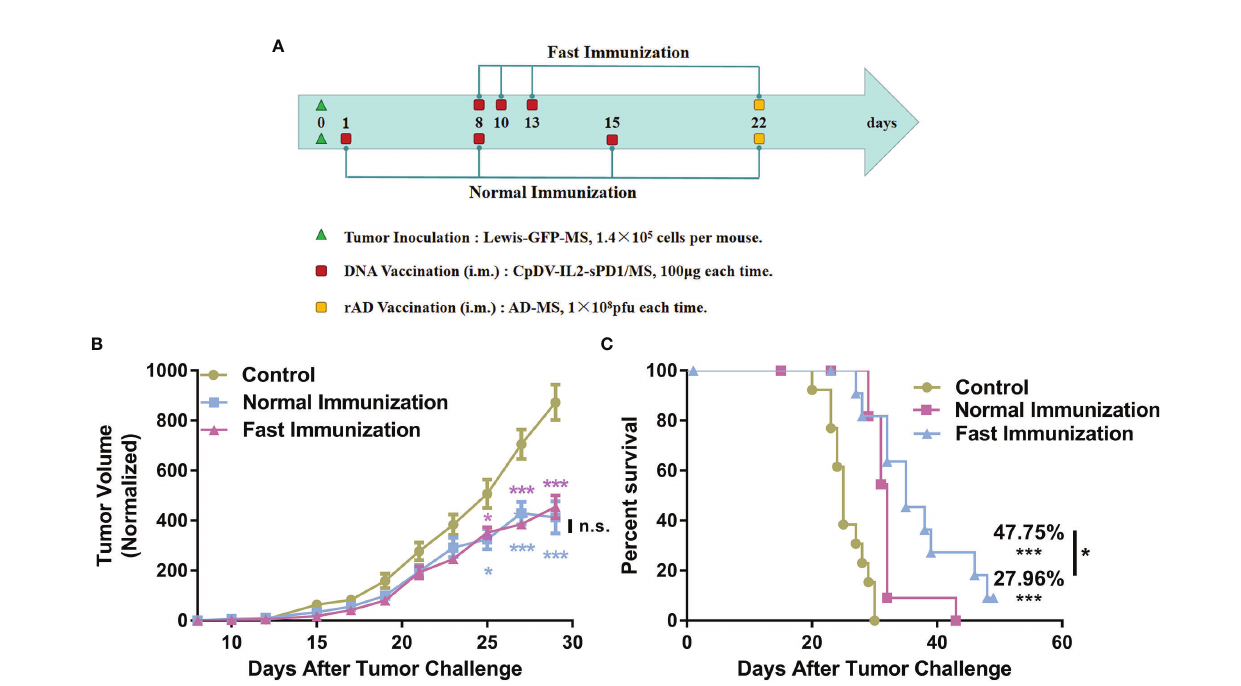
FIGURE 6 | Improved antitumor effect of the DNA vaccine under the fast immunization strategy, even in larger tumors. (A) Tumor incubation and vaccination strategy regimen. Lewis-GFP-MS cells (1.4 × 10 5 ) were injected subcutaneously into the right hind fl anks of C57BL/6 mice. In the normal immunization group (n = 12), the DNA vaccine was administered 1 day later and at 1-week intervals thereafter. In the fast immunization group (n = 12), the DNA vaccine was administered on day 8, when the tumor volume reached approximately 50 mm 3 . The following two vaccinations were administered on days 10 and 13: 1 × 10 8 pfu rAd on day 22 in both groups and PBS in control group mice (n = 13). (B) Tumor growth curves. Tumor volume measurements were taken beginning from day 8 after tumor cell inoculation. (C) Survival analysis was conducted by recording the death of tumor-bearing mice (* p < 0.05, *** p < 0.001, n.s., p >